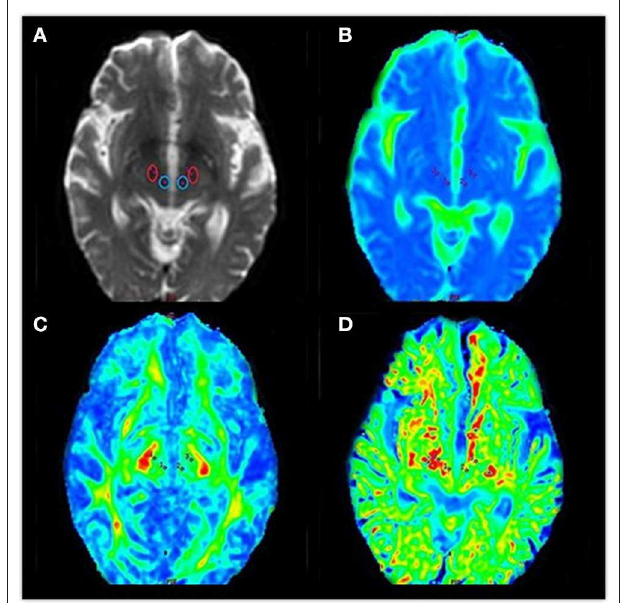
FIGURE 4 | Diffusional kurtosis images of volumes of interest in the bilateral red nucleus and substantia nigra (A–D) . (A) Volumes of interest in the bilateral red nucleus and substantia nigra. We obtained data from maps of the (B) mean diffusivity, (C) fractional anisotropy, and (D) mean